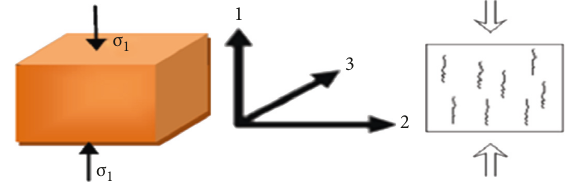
Figure 4: Crack propagation on a compressed sample.